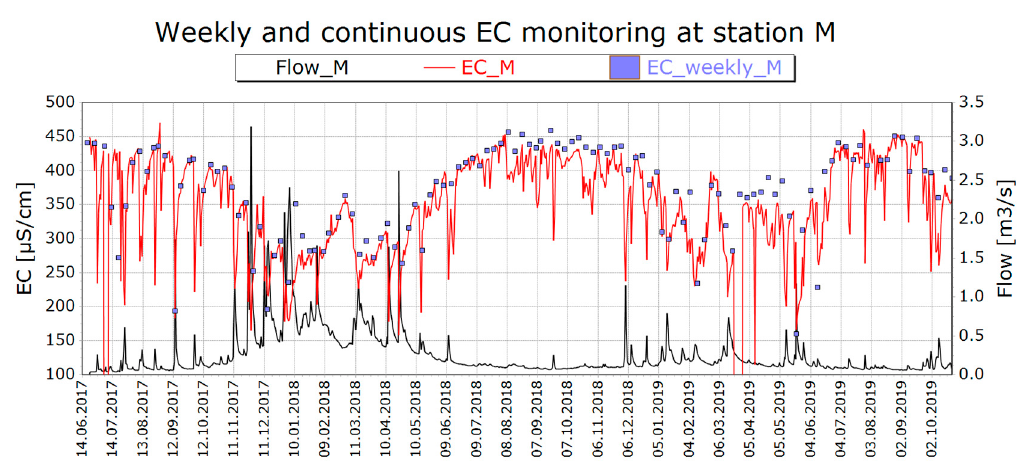
Figure 9. Continuous EC monitoring at stations M, N and O. Daily mean flow and EC are plotted. Time periods with missing values are highlighted in the red boxes and are excluded from evaluation. Daily mean flow data acquired from the HLNUG [33].